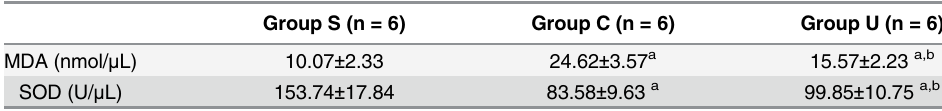
Table 2. MDA and SOD in kidney tissues in three